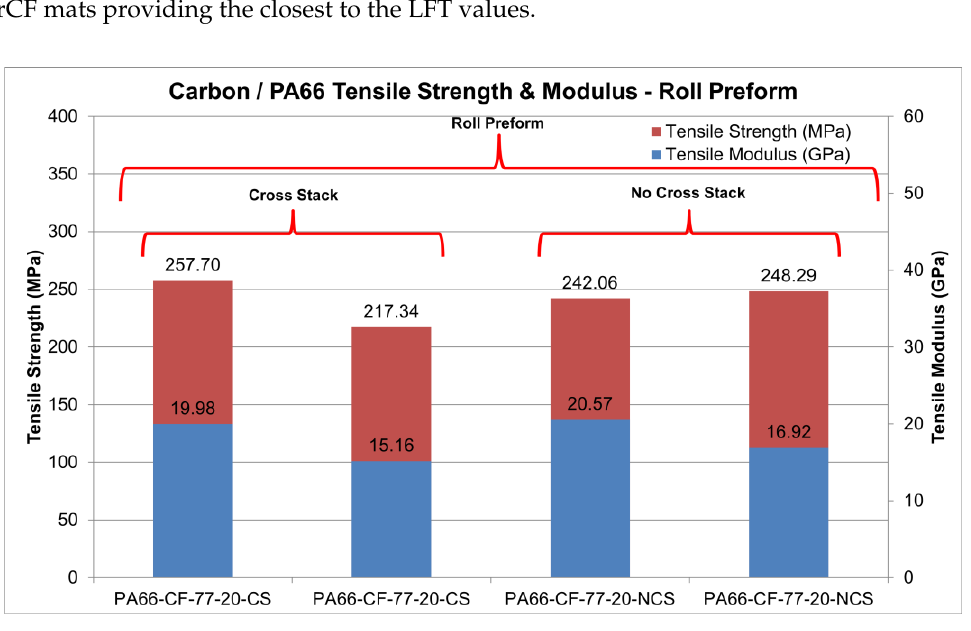
Figure 5. Comprehensive summary of tensile strength and tensile modulus for ‘roll’ form C/PA66.